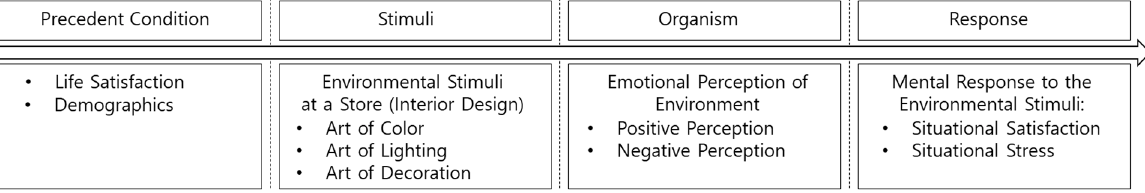
Figure 1. Conceptual model of the study.